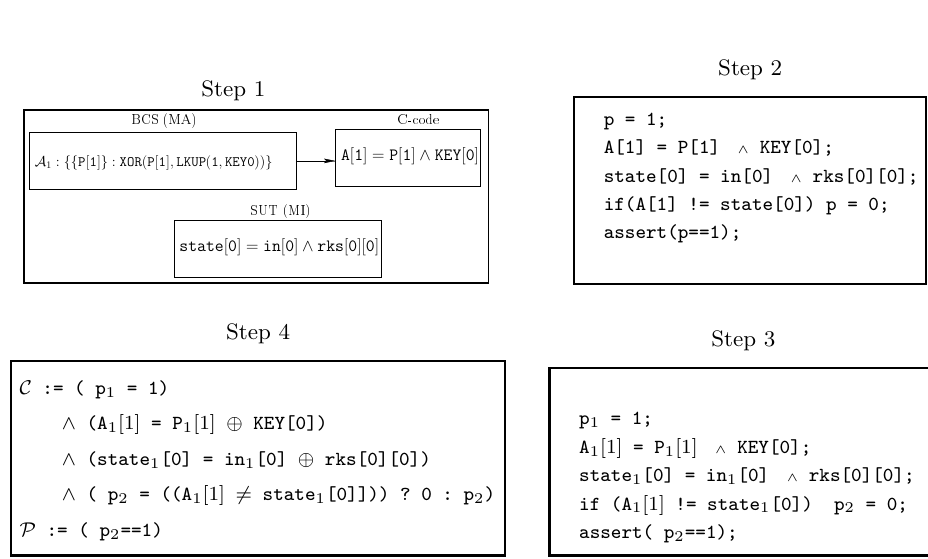
Figure 8: Steps involved for verifying equivalence between MA and MI.